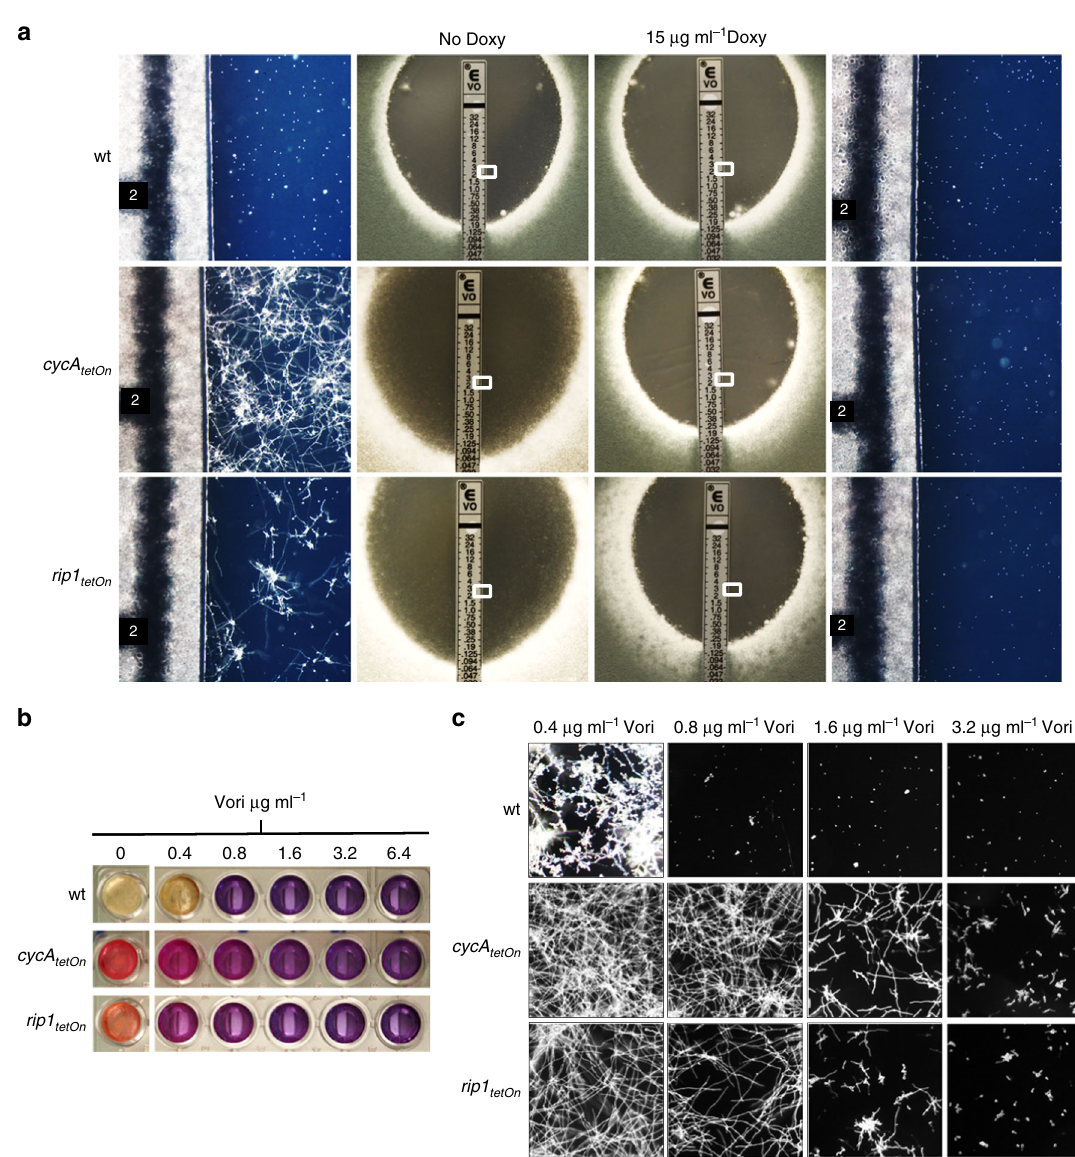
Fig. 5 The fungicidal activity of azoles depends on the functionality of the conventional mitochondrial electron transport chain. a 1 × 10 6 conidia of wild-type (wt) and of the conditional cytochrome c ( cycA tetOn ) and complex III ( rip1 tetOn ) mutants were spread on Sabouraud agar plates. When indicated, medium was additionally supplemented with 15 µ g ml − 1 doxycycline to induce the conditional promoter ( + Doxy). Voriconazole Etest strips were applied and plates were incubated at 37 °C. Representative photos were taken after approximately 48 h. The panels next to the macroscopic Etest strip photos show magni fi cations of the framed sections. b , c Conidia of the indicated strains were inoculated in Sabouraud medium supplemented with resazurin (cell viability marker, 0.1 µ g ml − 1 ) and the indicated amount of voriconazole and incubated at 37 °C. Macroscopic ( b ) and microscopic ( c ) images were